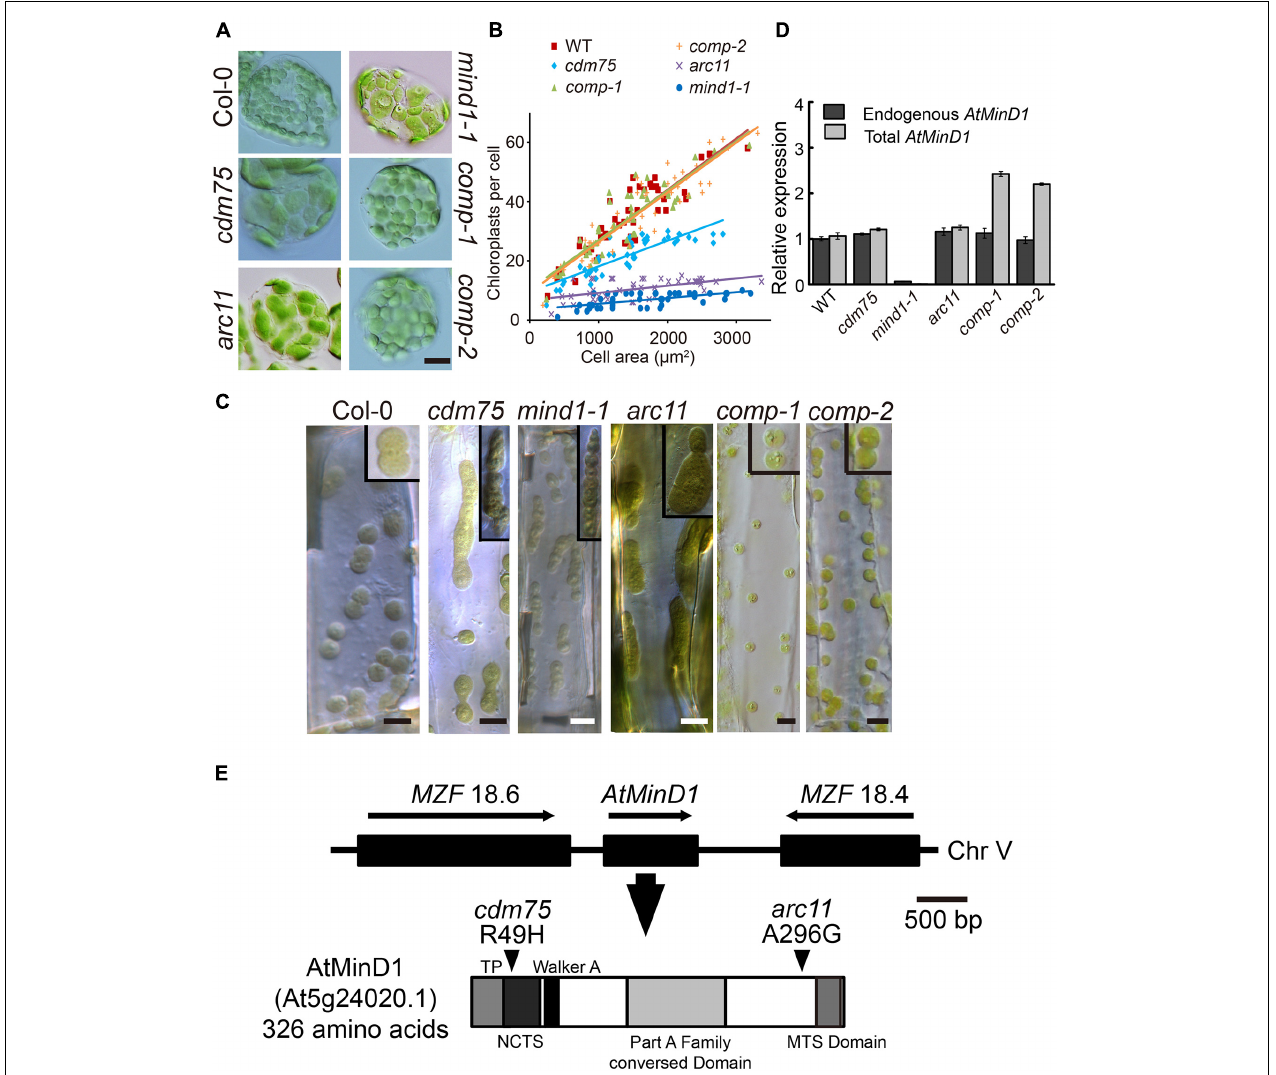
FIGURE 1 | Analyses of phenotype and mutation point of AtMinD1 in cdm75 . (A) Different chloroplast division phenotypes of Arabidopsis leaf mesophyll cells in 25-day-old plants for Arabidopsis thaliana Columbia-0 (Col-0) (wild-type), cdm75 , arc11 , mind1-1, and cdm75 complemented with wild-type AtMinD1 transgene plants [35S-AtMinD1-HA/ cdm75 -1 ( comp-1 ) and 35S-AtMinD1-HA/ cdm75 -2 ( comp-2 )]. Scale bars = 10 µ m. (B) Graph of chloroplast number relative to cell size in the 25-day-old plants. Best-fit lines have slopes of 0.0181 ( R 2 = 0.79), 0.092 ( R 2 = 0.76), and 0.0173 ( R 2 = 0.75) for the lines shown in (A) . (C) Differential interference contrast (DIC)-single optical sections of dividing chloroplasts in Arabidopsis leaf hypocotyls cells of the lines shown in (A) . Scale bars = 5 µ m. (D) Quantification of endogenous and total AtMinD1 transcripts in the Arabidopsis plants. Total RNAs from whole seedlings of Arabidopsis, the lines shown in (A) , were analyzed with a real-time PCR system. Primer sets specific to the coding region and the 3’-UTR of AtMinD1 were employed to monitor total (dark gray bars) and endogenous (light gray bars) AtMinD1 transcript levels, respectively. Amounts of AtMinD1 transcripts relative to AtUBQ are shown as the mean ± SD (with WT = 1) from three different plant samples. (E) Chromosomal location of AtMinD1 and the domain structure of its product. Single base substitution of AtMinD1 at position arginine (Arg) (49) in the specific fragment, changing Arg to histidine (His), is indicated by